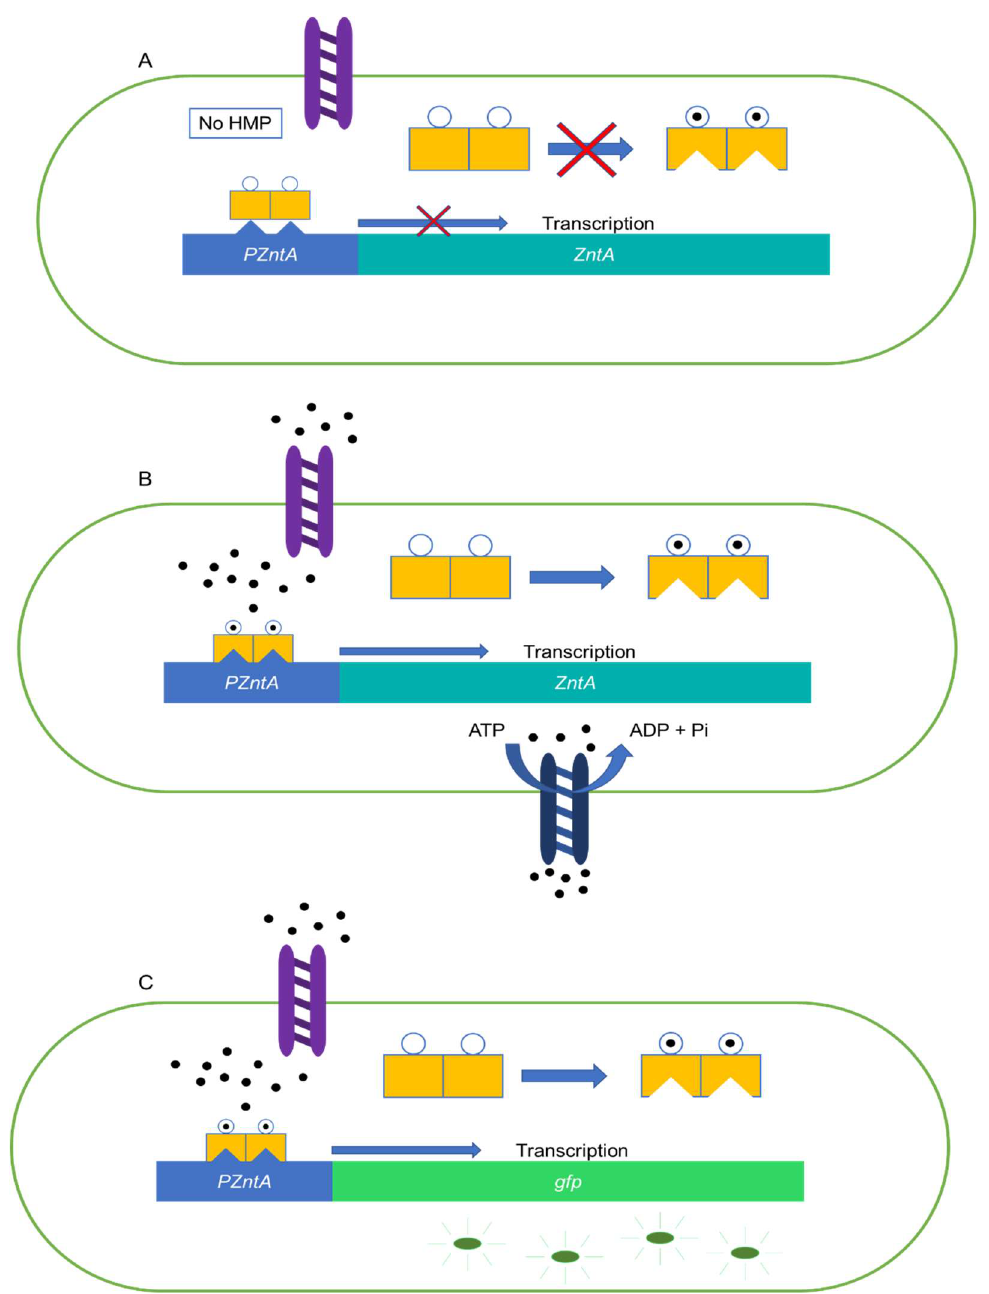
Figure 3. Znt regulation mechanism. ( A ) Znt regulation mechanism in absence of heavy metal ions. ( B ) Znt mechanism in presence of heavy metal ions. ( C ) Genetically modified bacteria synthesing gfp under the presence of heavy metal particles.